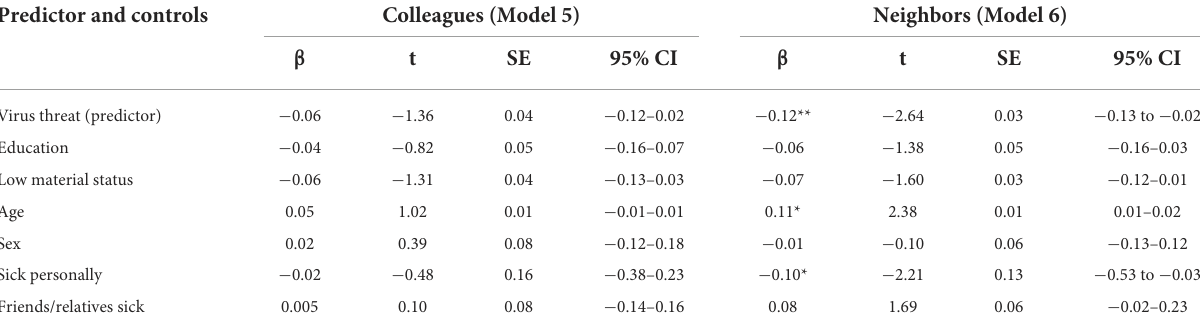
TABLE 4 Relation between perceived coronavirus threat and perceived closeness with colleagues and neighbors (simple linear regression with control of demographic variables, N = 500). Predictor and